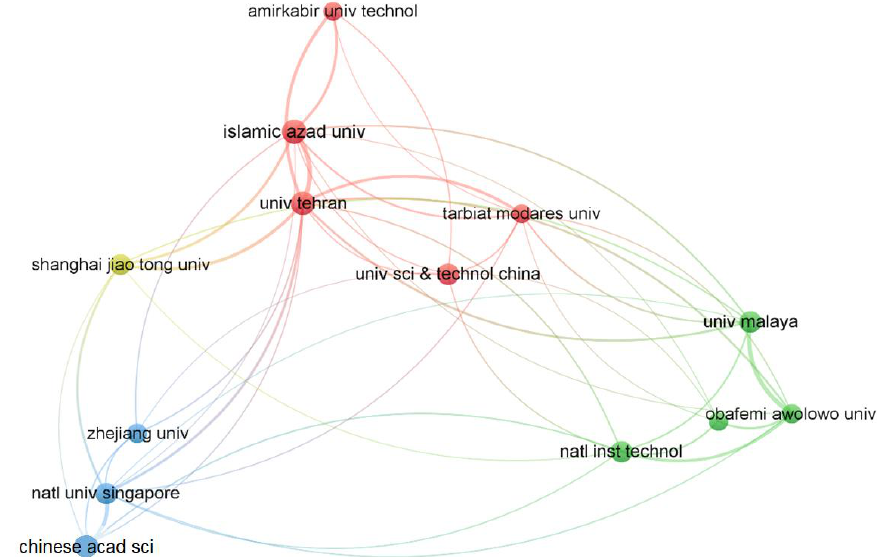
Figure 7. A citation map analysis based on the highest contributing institutions in AI in bioenergy research. Lines in between each institution represent an institution citing from another. The size of each node represents an institution’s contribution to the research. The colours of the nodes represent the location of the institutions.